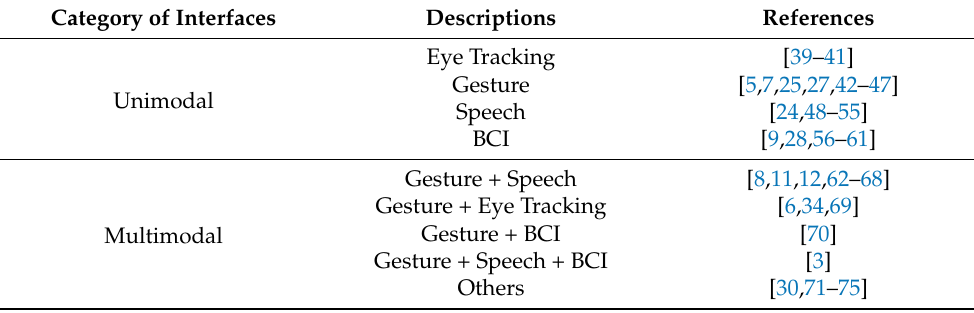
Table 1. Overview of core references for natural HCIs for